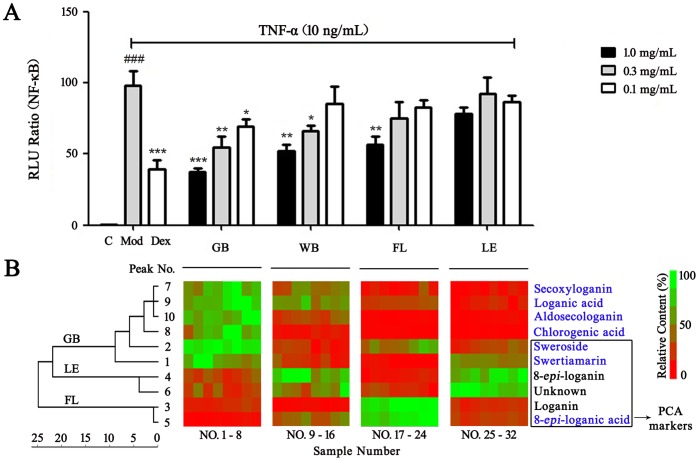
Effects of the different FLJ flower bud stages on NF-κB inhibition (A), the heat map and hierarchical cluster analysis of FLJ.A: The expression of NF-κB in TNF-α stimulated HEK 293 cells. The values are presented as the means ± SEM; n = 6 for each group. One (*), two (**) or three (***) indicate p<0.05, p<0.01 or p<0.001 vs the TNF-α treated group, respectively; ### indicates p<0.001 vs the control group. B: The relative contents of the marker ingredients and NF-κB inhibitors in different FLJ flower bud stages. Zero content was expressed as red and the largest content (100%) as green.